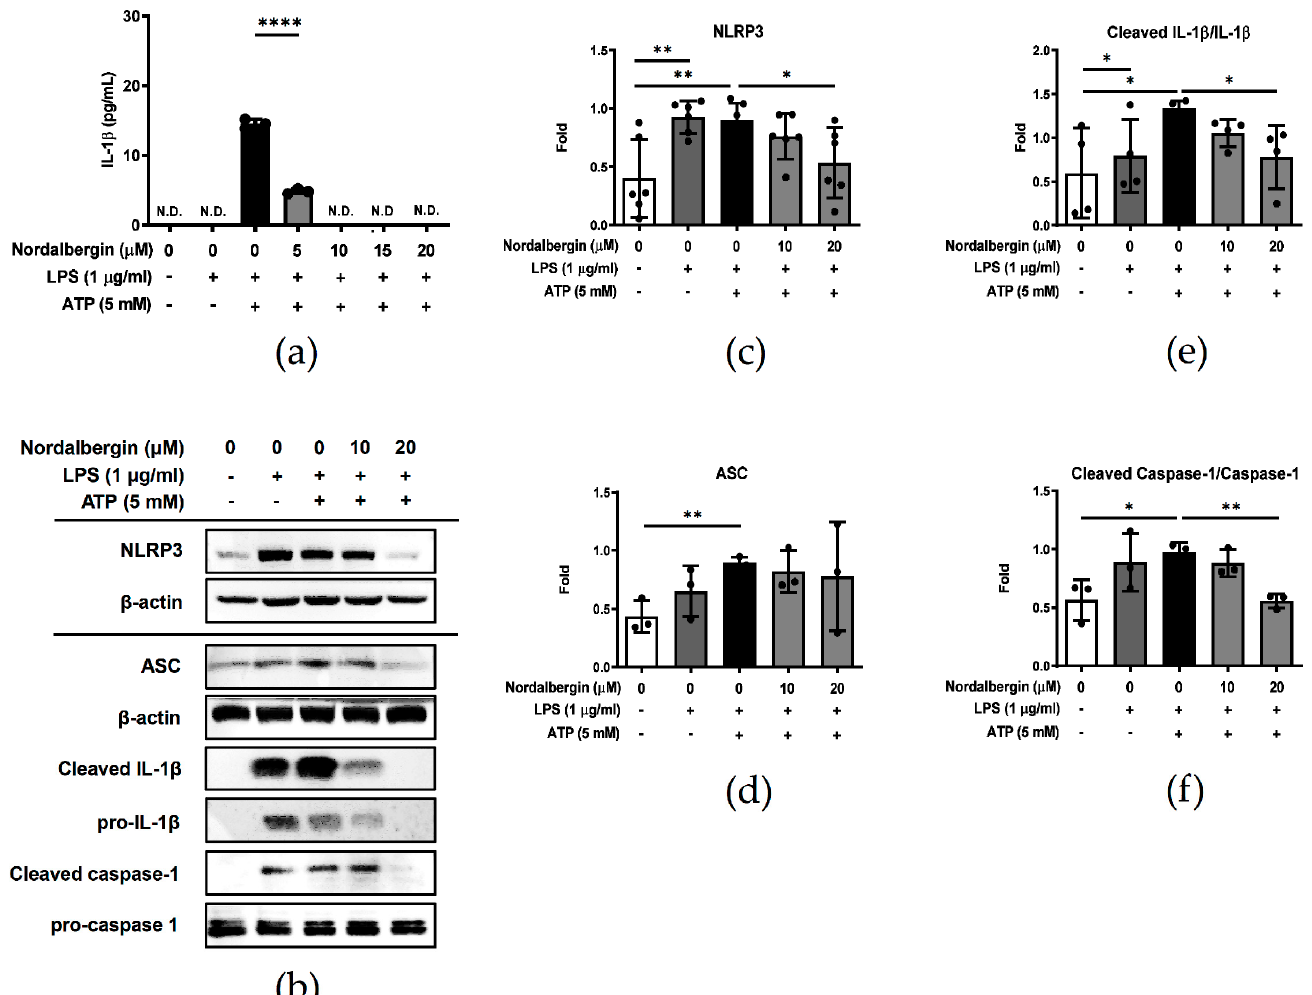
Figure 4. Effect of nordalbergin on the secretion of IL-1 β and the activation of NLRP3 inflammasome by LPS-stimulated BV2 cells. Cells were pretreated with different concentrations of nordalbergin for 30 min and primed with LPS for 5 h following treatment of 5 mM ATP. ( a ) The secretion of IL-1 β was analyzed by ELISA. ( b ) Expressions of NLRP3, ASC, cleaved-IL-1 β , pro-IL-1 β , cleaved-caspase-1 and pro-caspase-1 were examined by Western blot, with that of β -actin used as a loading control. The quantified results are shown in ( c – f ). N.D. means not detected. Data are presented as mean ± SD (n = 3–6; * p < 0.05, ** p < 0.01, **** p < 0.0001).